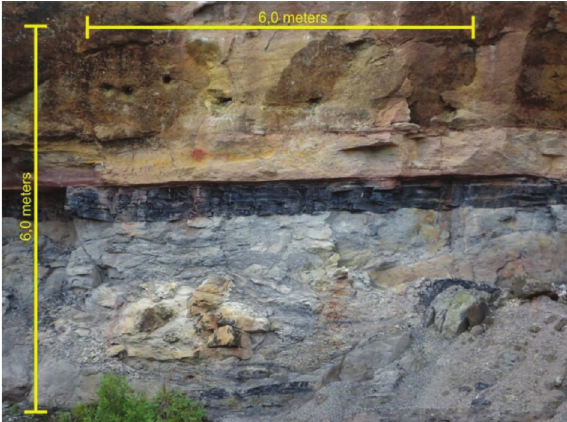
Figure 4: Study area A, Morro do Papal´eo outcrop, Rio Bonito Formation. From the base to top we can identify the diamictite (light gray, bottom part), the carbonaceous pelite (black, in the middle part), and the sandstone (light and medium brown, top part).